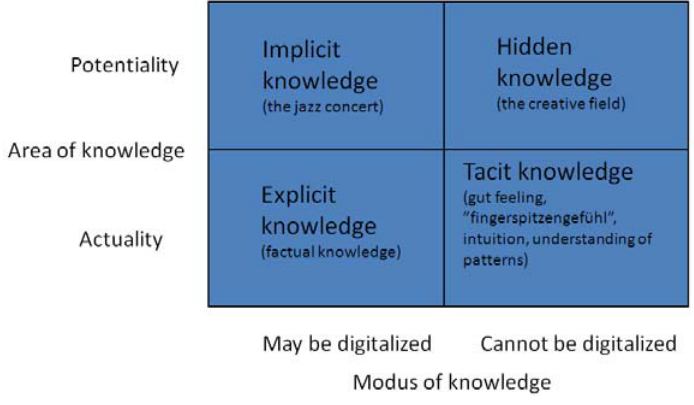
Fig. 2. The area of entrepreneurial